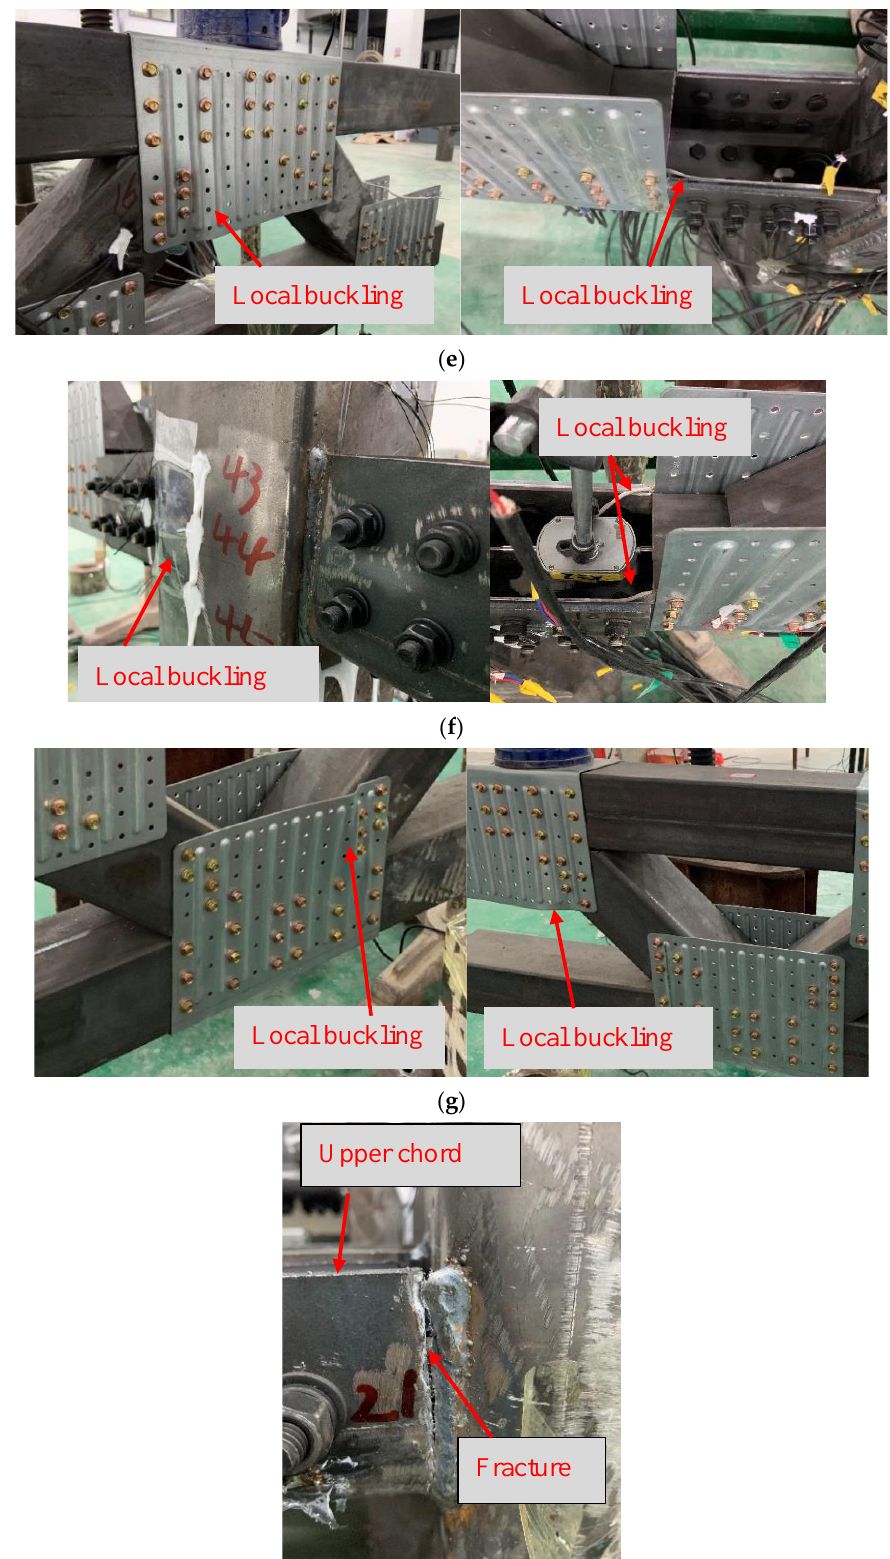
Figure 12. Local deformation and failure characteristics of the eight specimens. ( a ) JU60 − 1, ( b ) JU60 − 2, ( c ) JU60 − 3, ( d ) JU60 − 4, ( e ) JU100 − 1, ( f ) JU100 − 2, ( g ) JU100 − 3, ( h ) JU100 −